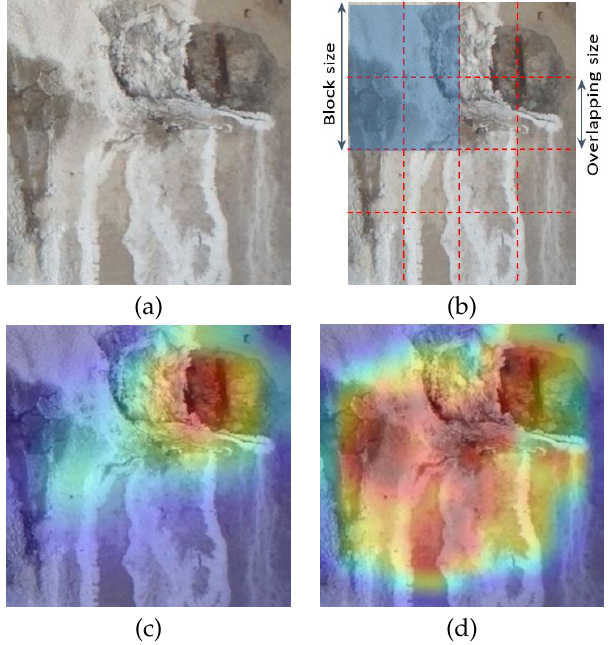
Figure 3. Illustration of the saliency extraction module for concrete defect detection: ( a ) in- put image, ( b ) overlapping block image subdivision, ( c ) global saliency extraction, and ( d ) local saliency